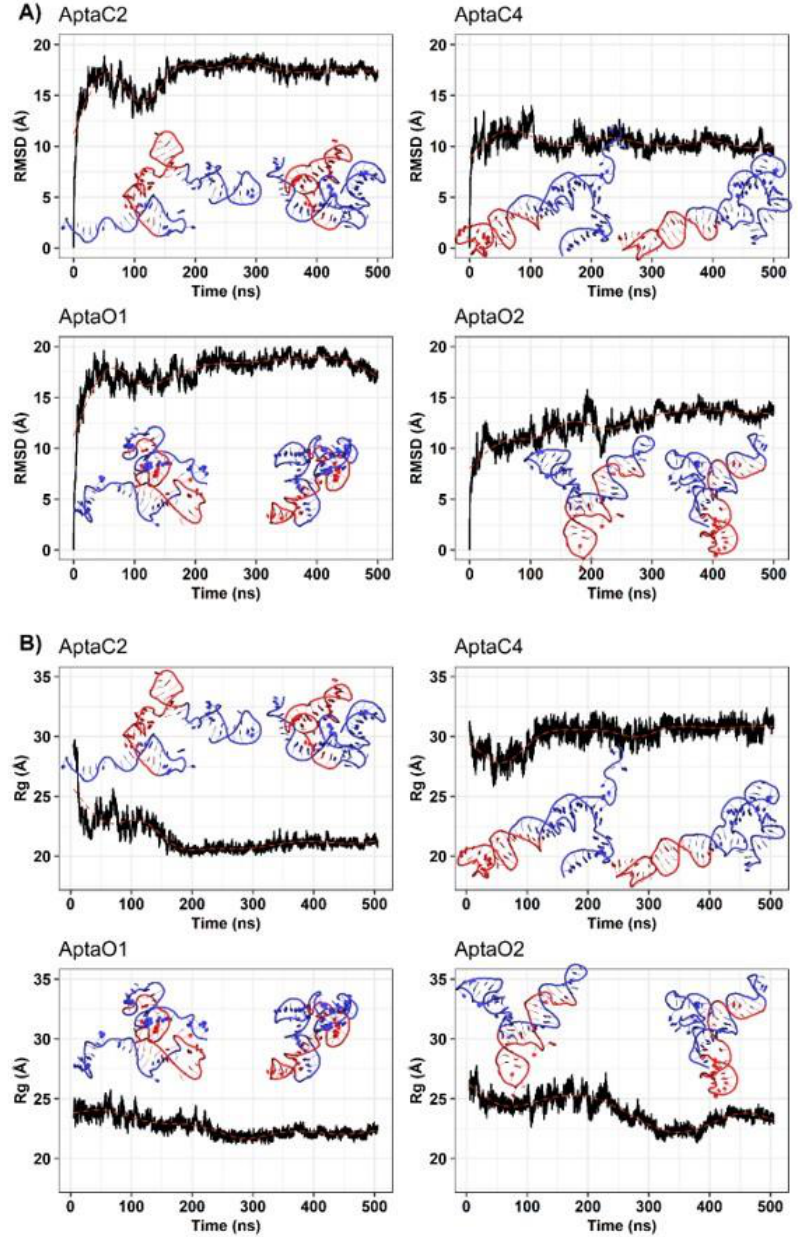
Figure 5. Root-mean-square deviations ( A ) and radius of gyration ( B ) throughout the molecular simulations. Aptamer structure representations corresponding to the initial production structure and the central structure resulting from clustering analysis of simulation are displayed within each plot. The regions of the adapter and central core are depicted in blue and red, respectively.